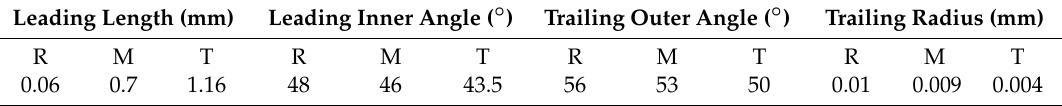
Table 11. Final parameters of the stator’s leading and trailing axial chords.